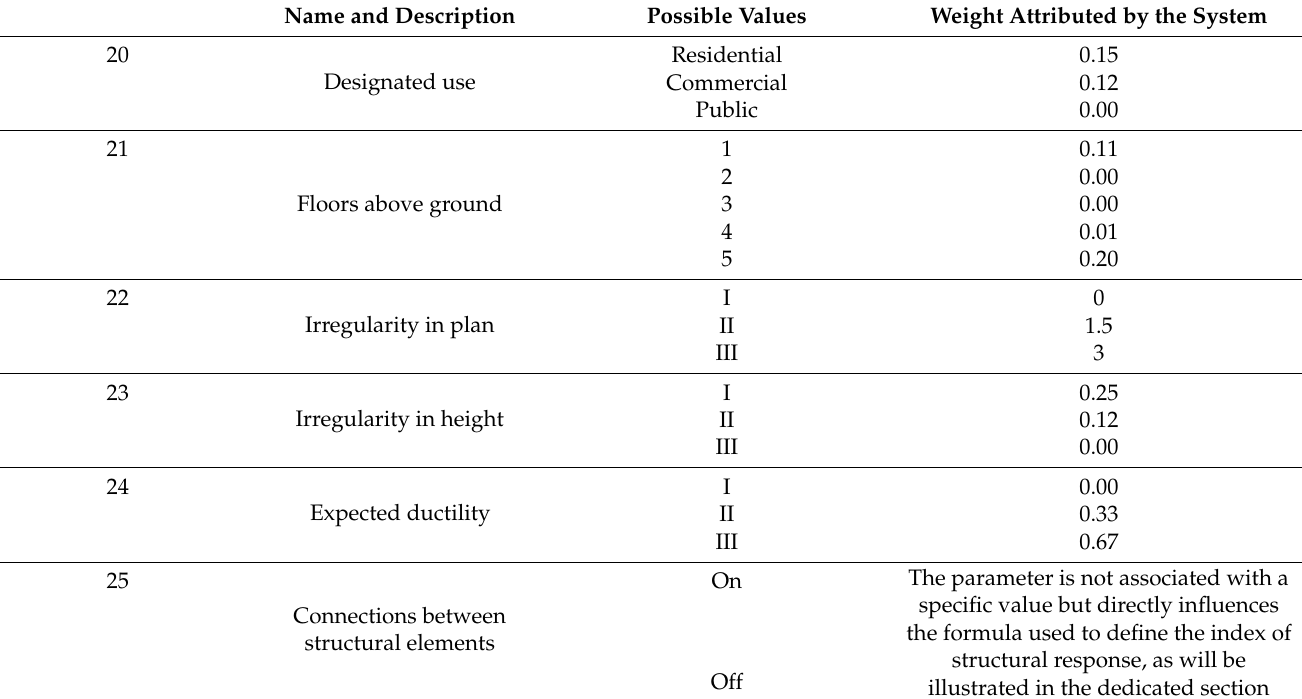
Table A4. Building characteristics.